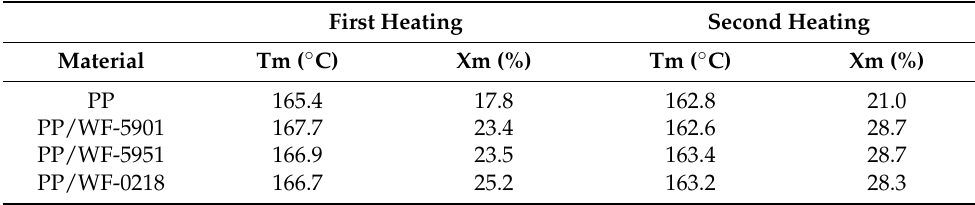
Table 2. Thermal parameters of PP and PP/WF